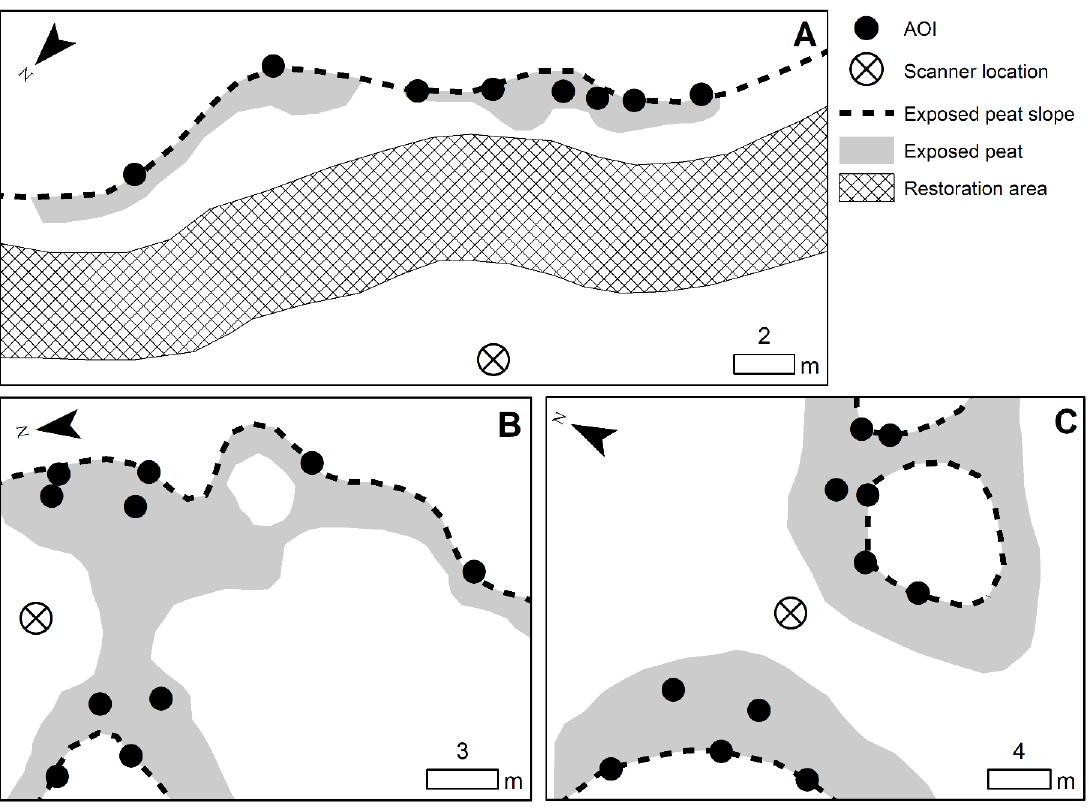
Figure 3. Schematic of study areas and survey strategy. A) Zalama, B) Ilsos de Zalama, C) Collado de Hornaza. Black circles indicate the centre of the selected